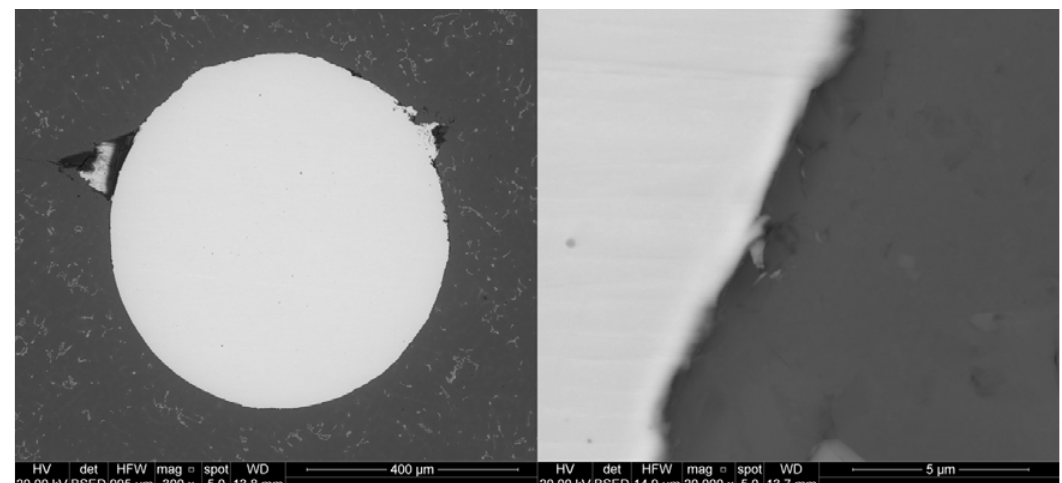
Figure 6: SEM micrographs of the two alloys and their coupling interface in the as-cast condition.